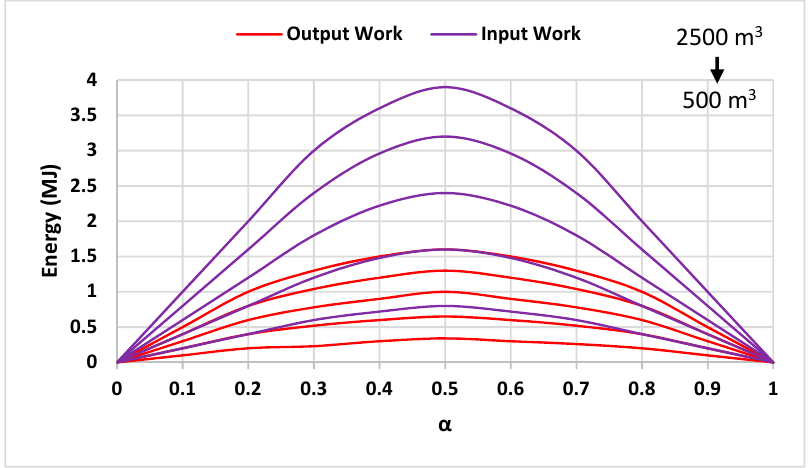
Figure 12. Changes in input and output work relative to α for the constant pressure of 20 MPa and different tank volumes (from 2500 to 500 with a step of 500 m 3 ).